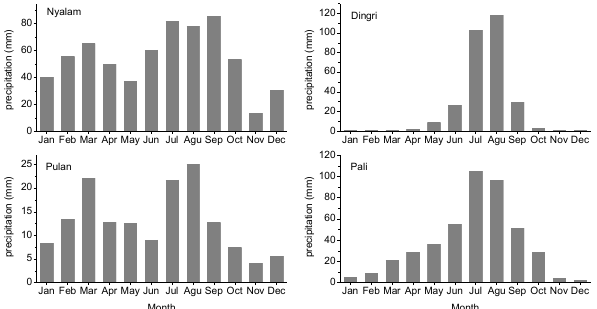
Fig. 3. Monthly long-term mean of precipitation at four weather sta- tions along the Himalayas (Nyalam, Pulan, Dingri, and Pali). Sea- sonal distribution of precipitation is calculated based on the meteo- rological data observed from January 1973 to January 2011.